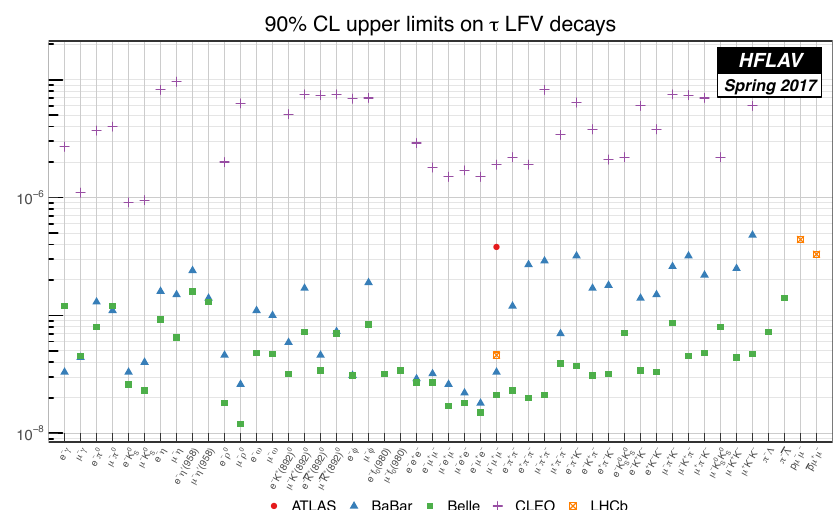
Figure 1: HFLAV summar plot on the upper limits for tau lepton-flavor-violating branching fractions. From [ 22 ]